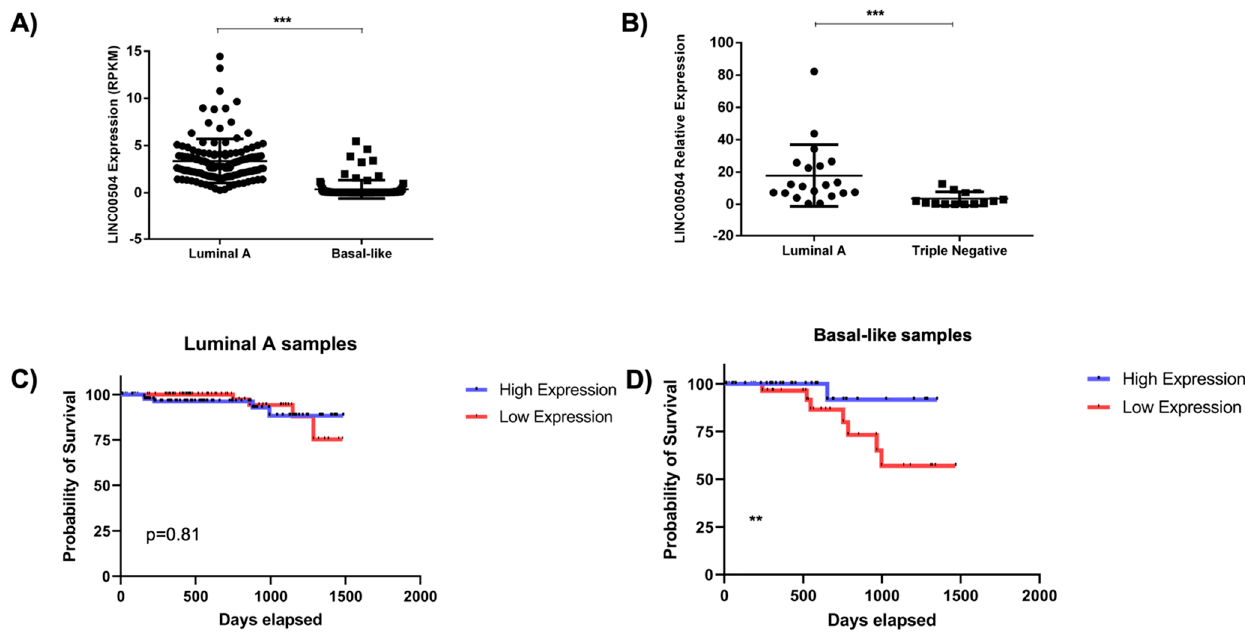
Figure 4. LINC00504 expression and its relationship with patients’ survival. ( A ) LINC00504 expression (RPKM) in TCGA BRCA cohort. In total, 231 luminal A and 98 basal-like samples were used, and LINC00504 is up-regulated in luminal A patients; ( B ) LINC00504 relative expression in a Brazilian’s patients’ cohort. In this cohort, 30 luminal A and 25 triple-negative samples were used, and we observed the same pattern of up-regulation in luminal A samples; ( C , D ) Survival analysis considering median LINC00504 expression value as cut-off in Luminal A samples and Basal-like samples, respectively. Red and blue lines refer to patients with low and high expression, respectively. ** p < 0.05 and *** p < 0.01.